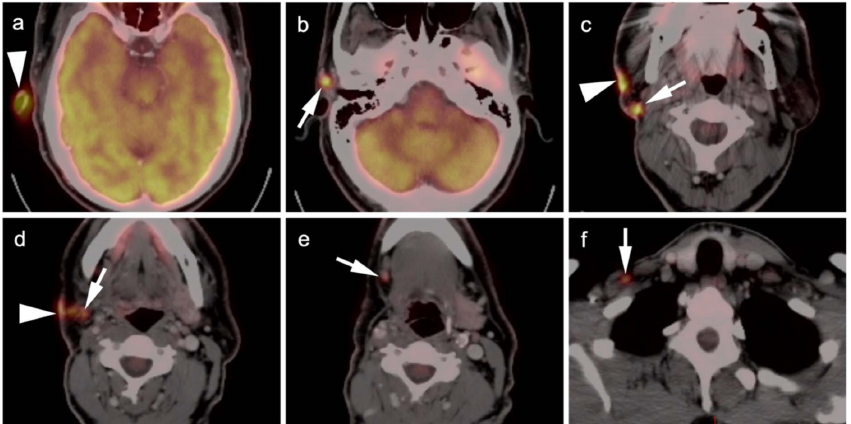
Figure 2. Melanoma of the right ear, metastatic to skin and multiple regional lymph nodes (patient had prior neck dissection for a previous melanoma). Six axial images from an FDG PET-CT scan of the head and neck are shown. ( a ) Primary tumor in the superior aspect of the right ear (white arrowhead). ( b ) Extension to a right preauricular lymph node (white arrow). ( c ) Extension along the skin (white arrowhead) with involvement of a parotid tail node (white arrow). ( d ) Further extension along the right skin (white arrowhead) with involvement of a right level 2 node. ( e ) Extension to a right submandibular node (white arrow). ( f ) Extension to a right supraclavicular node (white